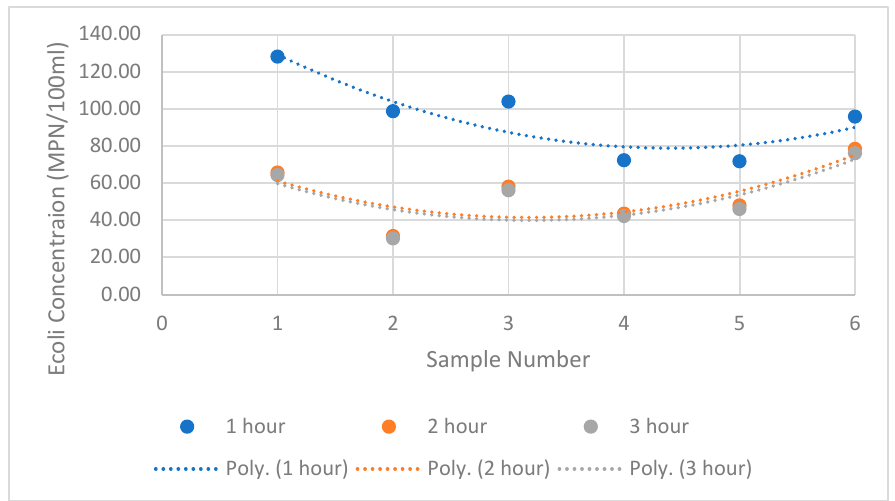
Figure 4. Variation of E. coli count with time with different hybrid mixtures.